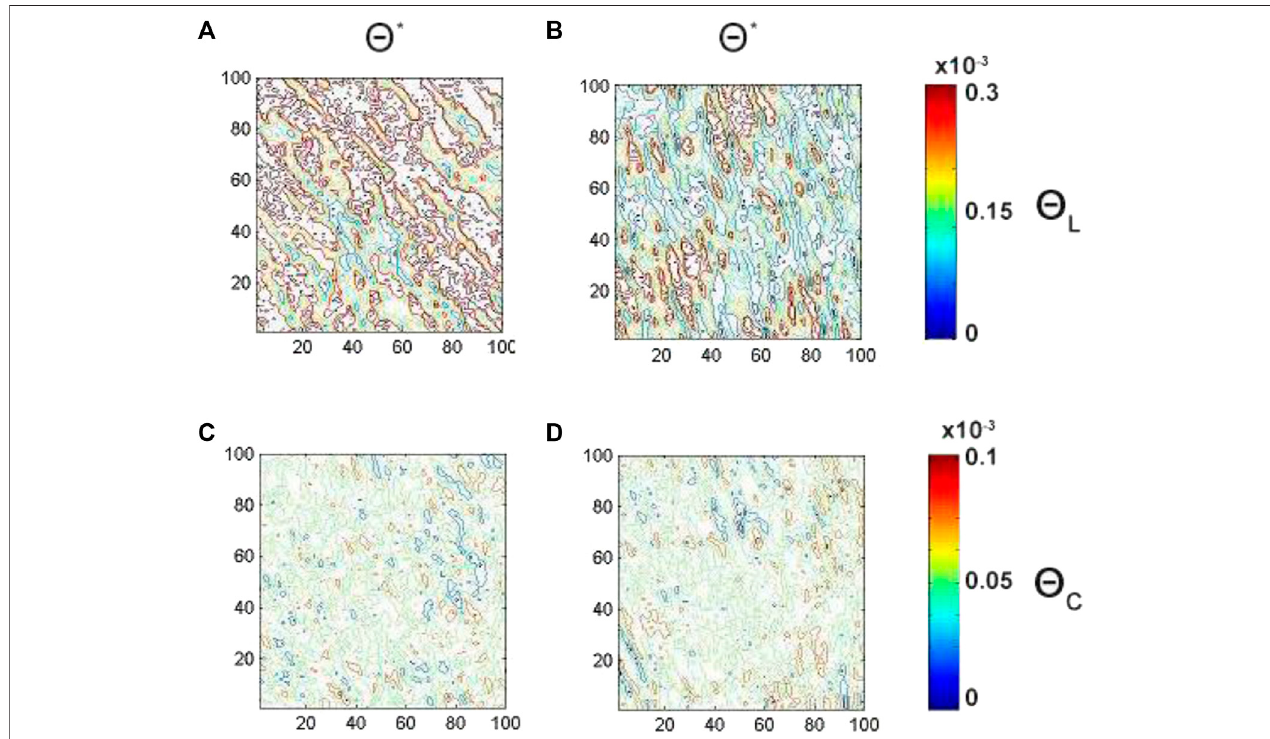
FIGURE 8 | Embossed topographic maps of linear (A, B) and circular (C, D) birefringence of ACI (left column) and CHD (right column) myocardial histological sections. The determined optimal phase planes are θ p ( ϕ L , ϕ C ) (cid:1) 0 . 7rad.